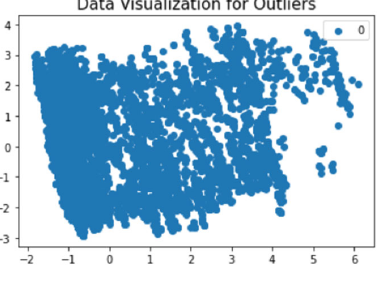
Fig. 1. Detecting outliers in our dataset Fig. 2. The shape of our dataset after converting it to a